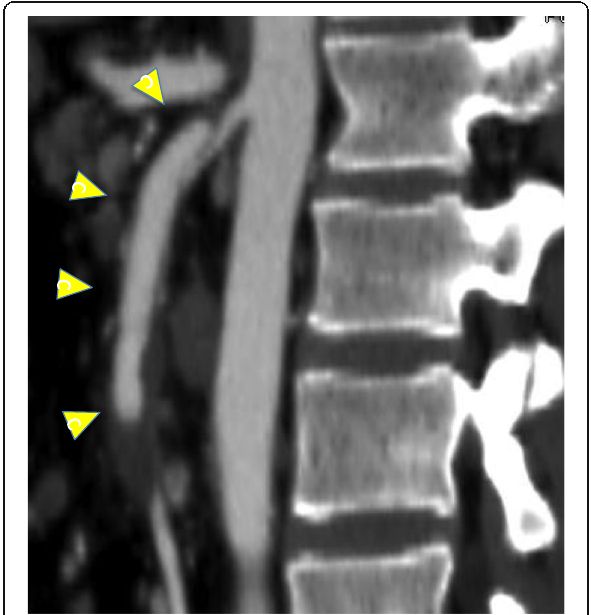
Fig. 2 Computed tomography image 36 days after the symptom onset. Sagittal multiplanar reconstruction computed tomography showed that the false lumen was enhanced (arrowheads), but the true lumen was still compressed and thrombosed at the distal